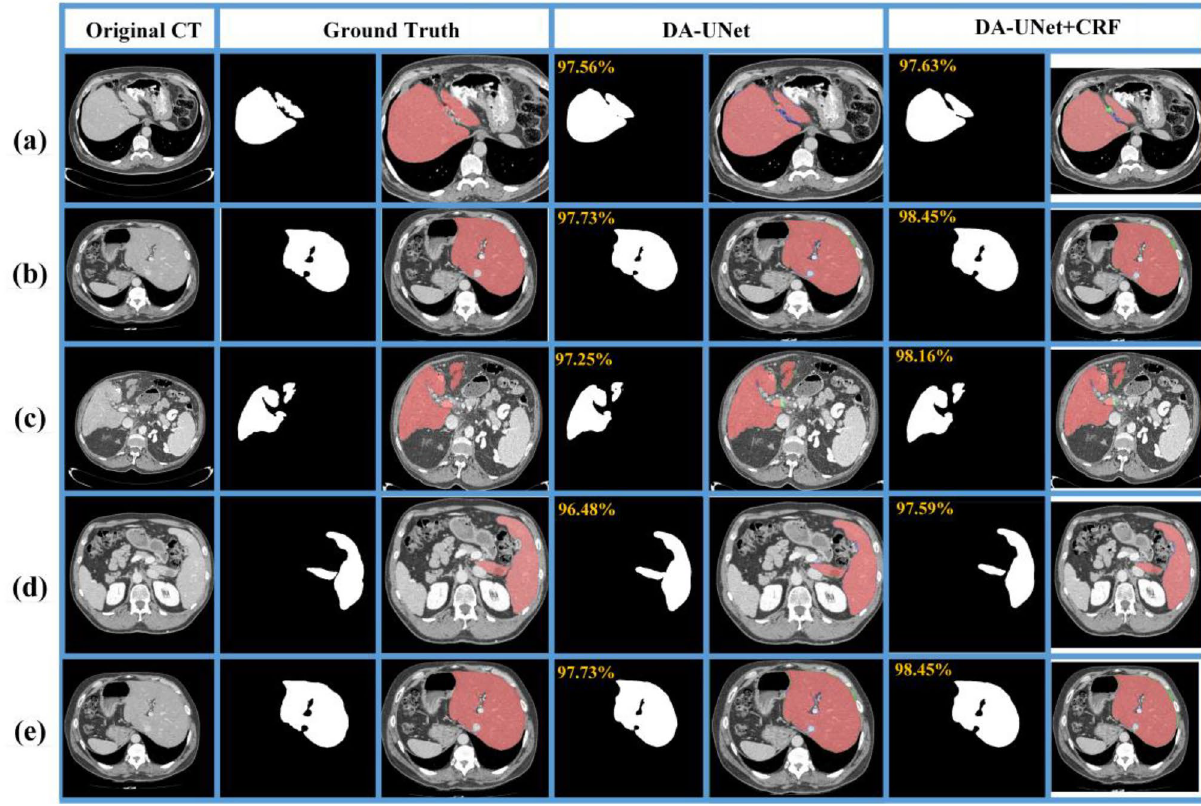
Figure 7. Visualization of segmentation error with the proposed 3D DA-UNet and post-processing on the LiTS17 dataset. (The red region denotes the ground truth, blue/green region represents the under-/over- segmentation. ( a , b ) liver with fuzzy boundaries, ( c , d ) liver with the obvious discontinuous regions, ( e ) liver with blood vessels